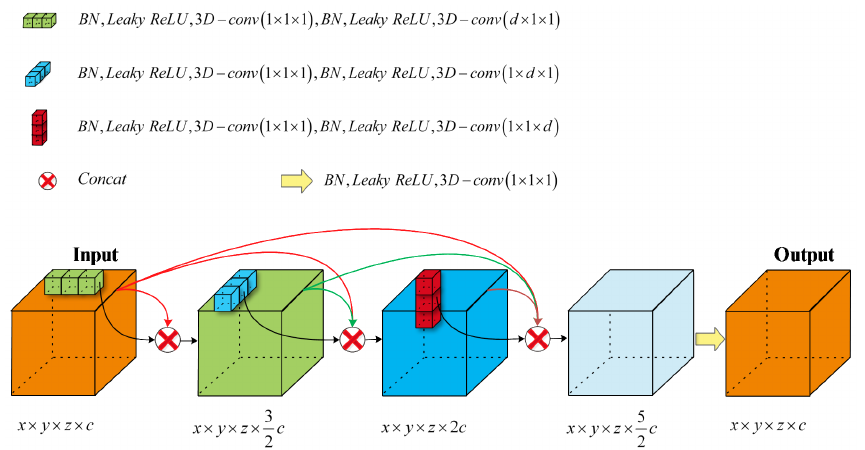
Figure 1. Overview of 3D Dense Separated Convolution (3D-DSC). For demonstration purposes, we just show one channel of the input and the feature